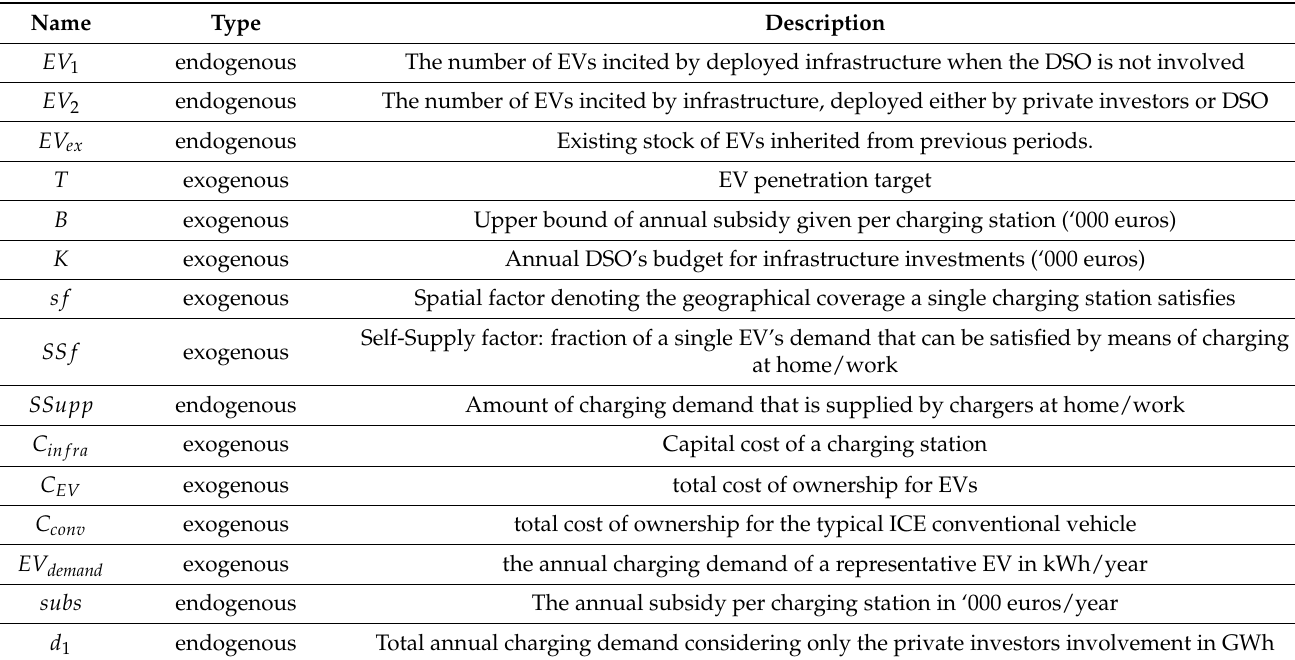
Table 3. The variables and parameters of the